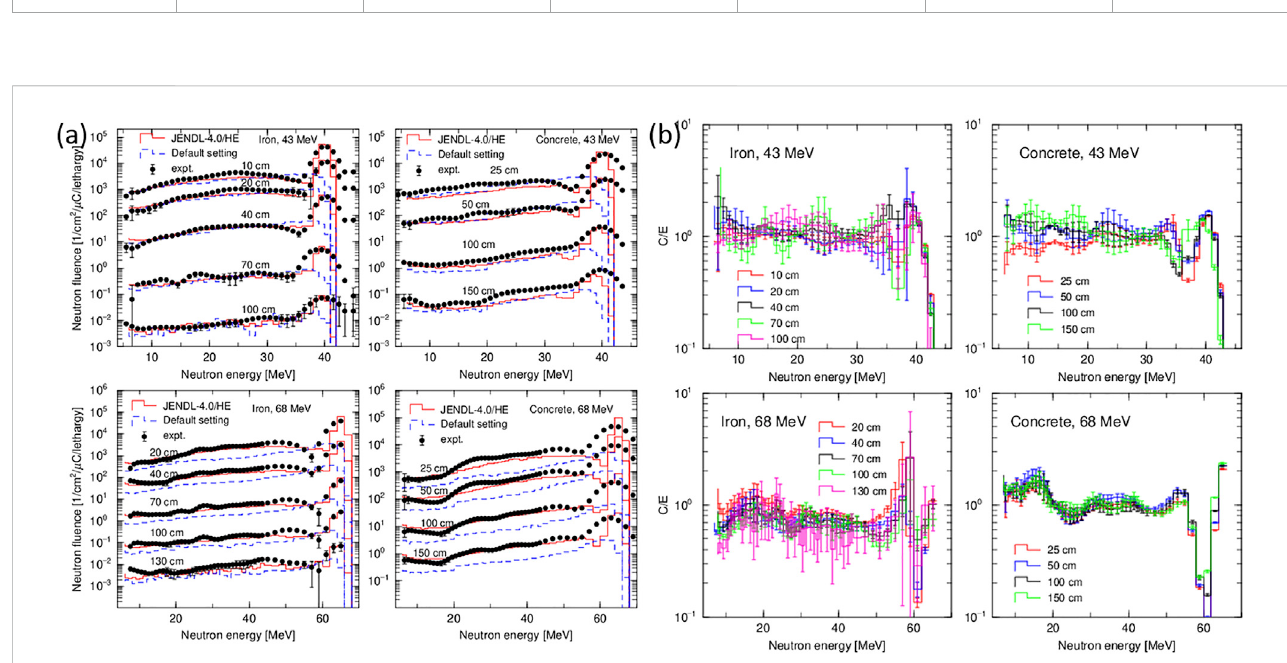
FIGURE 8 (A) Neutron energy spectra after transmission through iron and concrete shields for the TIARA experiments with the 43- and 68-MeV proton incident reactionsonlithiumtarget.Theexperimentalerrorsincludeonestandarddeviationbasedonafulluncertaintyanalysis. (B) Theratioofcalculationresultswith JENDL-4.0/HE and experimental data to the neutron